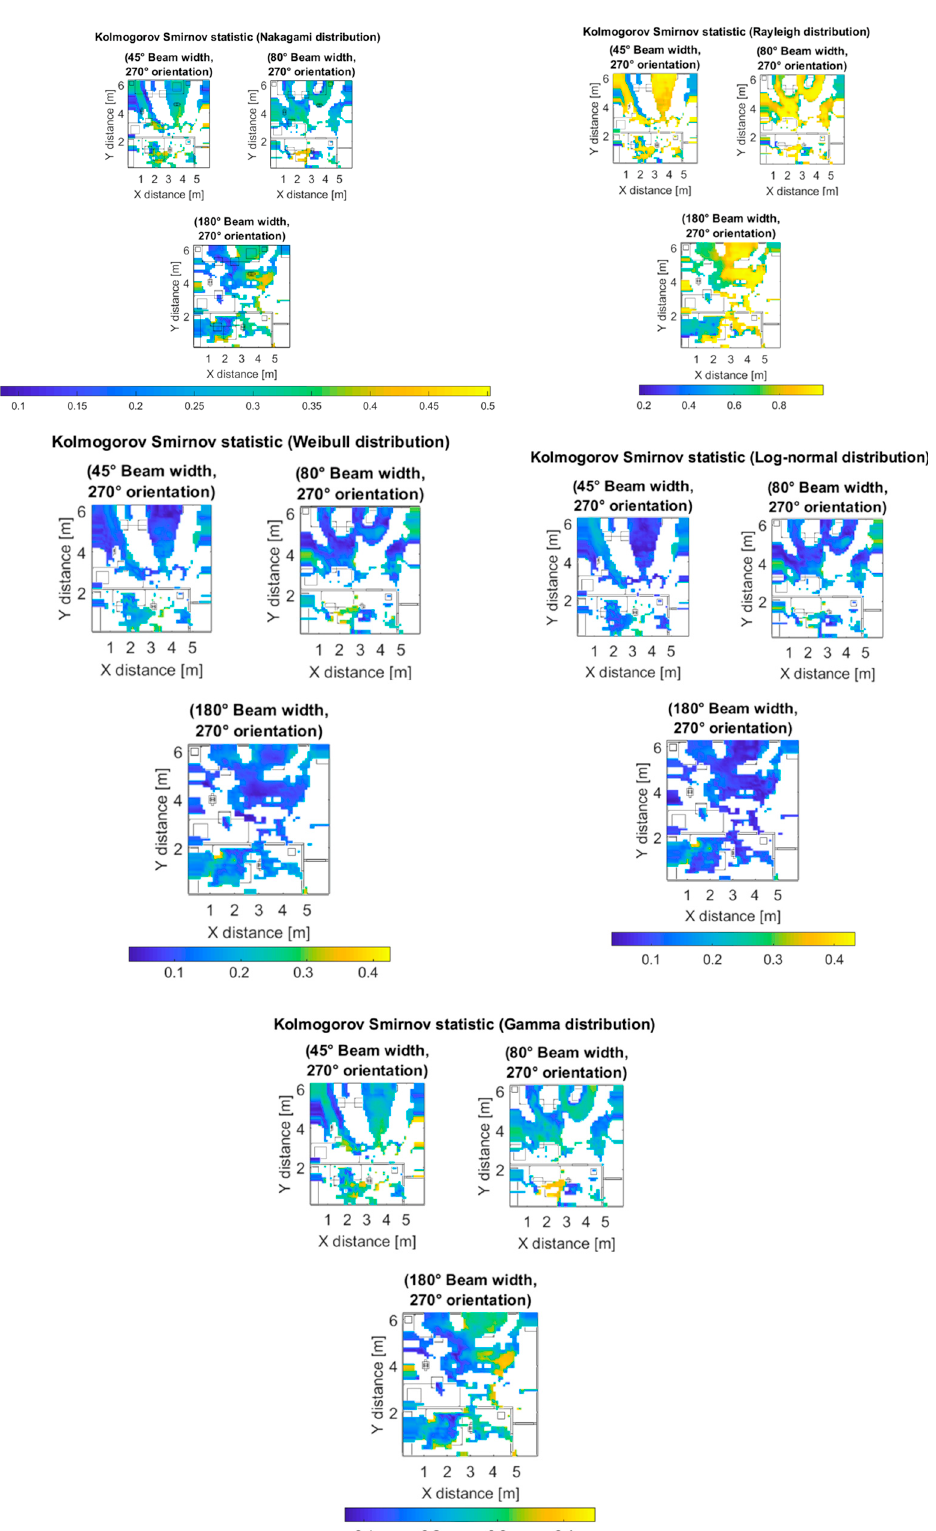
Figure 14. Kolmogorov–Smirnov statistic between the data from simulation and Nakagami distribution ( top left ), Rayleigh distribution ( top right ), Weibull distribution ( center left ), Log-normal distribution ( center right ), and Gamma distribution ( bottom ), for the indoor scenarios.